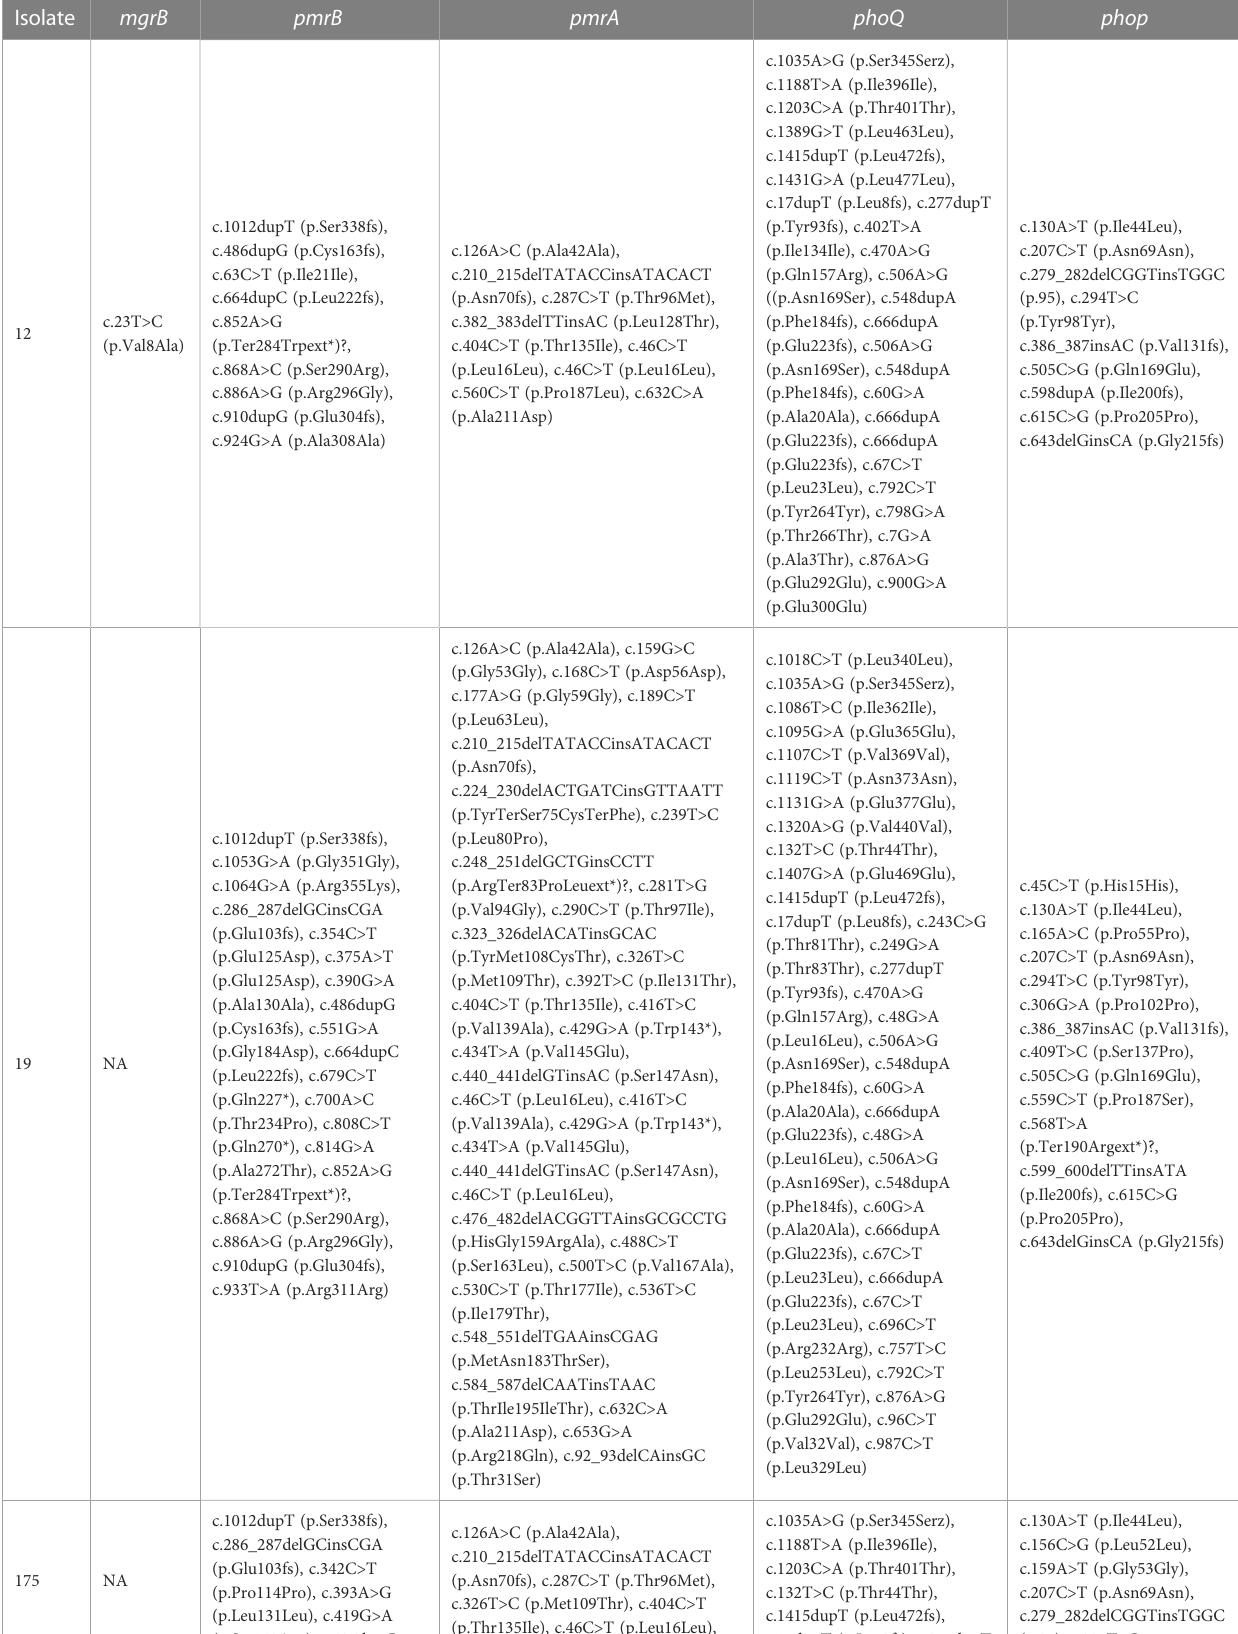
TABLE 4 Genetic variations in pmrA , pmrB , phoQ , phoP , and mgrB of the polymyxin-resistant E. coli isolates.